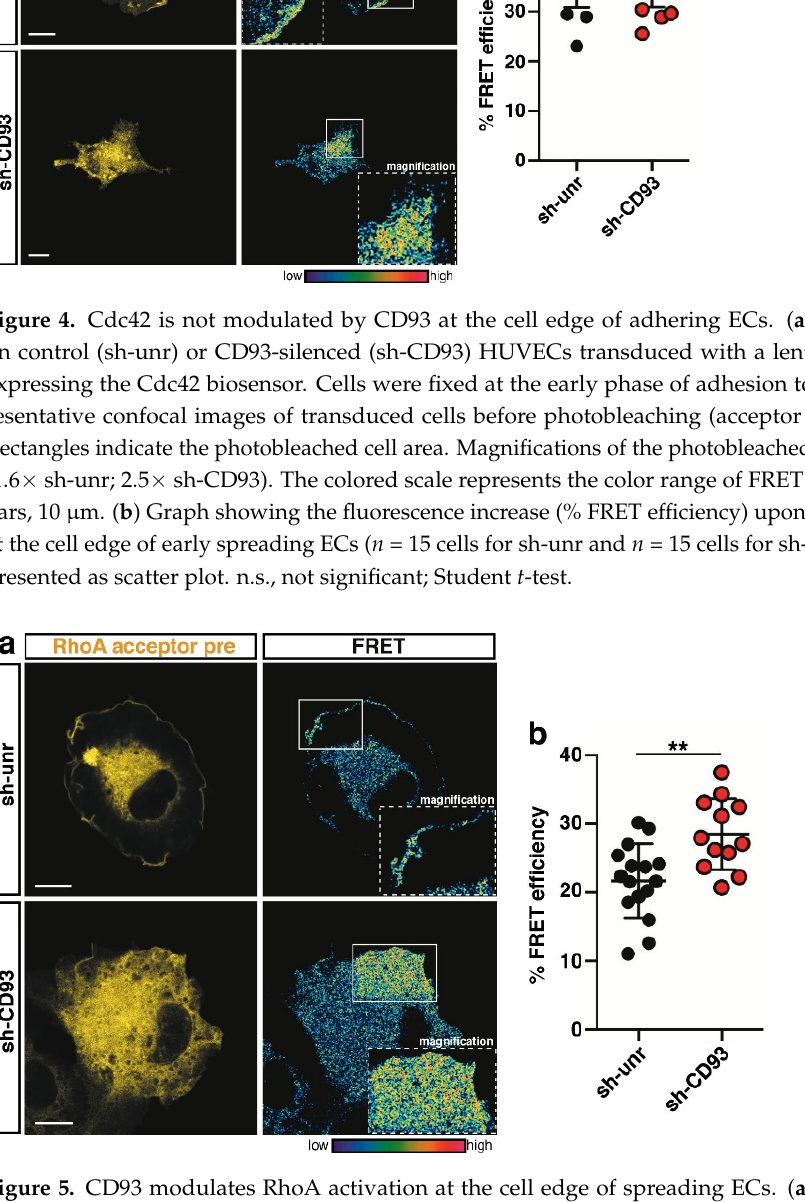
Figure 5. CD93 modulates RhoA activation at the cell edge of spreading ECs. ( a ) FRET analysis on control (sh-unr) or CD93-silenced (sh-CD93) HUVECs transduced with a lentiviral construct expressing the RhoA biosensor. Cells were fixed at the early phase of adhesion to the ECM. Representative confocal images of transduced cells before photobleaching (acceptor pre) are shown. Rectangles indicate the photobleached cell area. Magnifications of the photobleached area are shown (1.8 × sh-unr; 1.5 × sh-CD93). The colored scale represents the color range of FRET efficiency. Scale bars, 10 µ m. ( b ) Plot showing the fluorescence increase (% FRET efficiency) upon photobleaching at the cell edge of early spreading ECs ( n = 16 cells for sh-unr and n = 12 cells for sh-CD93). Data are presented as scatter plot. ** p < 0.01; Student t -test.